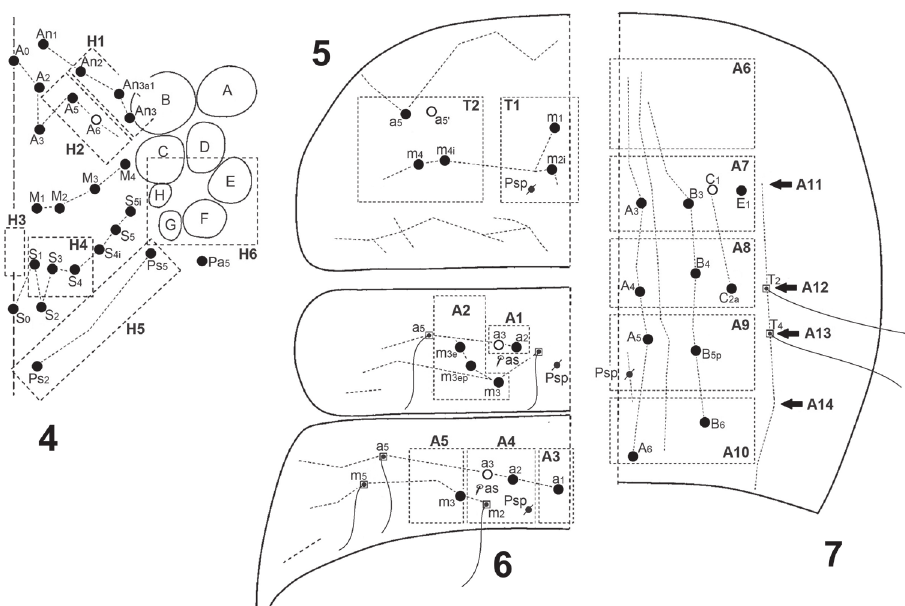
Figures 4–7. Entomobrya virginiae Arbea, sp. nov. 4 head chaetotaxy 5 Th II chaetotaxy 6 Abd II–III chaetotaxy 7 Abd IV chaetotaxy. Symbols: open circle = Mc that could be absent in male and juvenile specimens but present in females; closed circle = Mc that are always present; black chaetae-like = sensilla; black circles with a cross line = pseudopores; long chaetae =